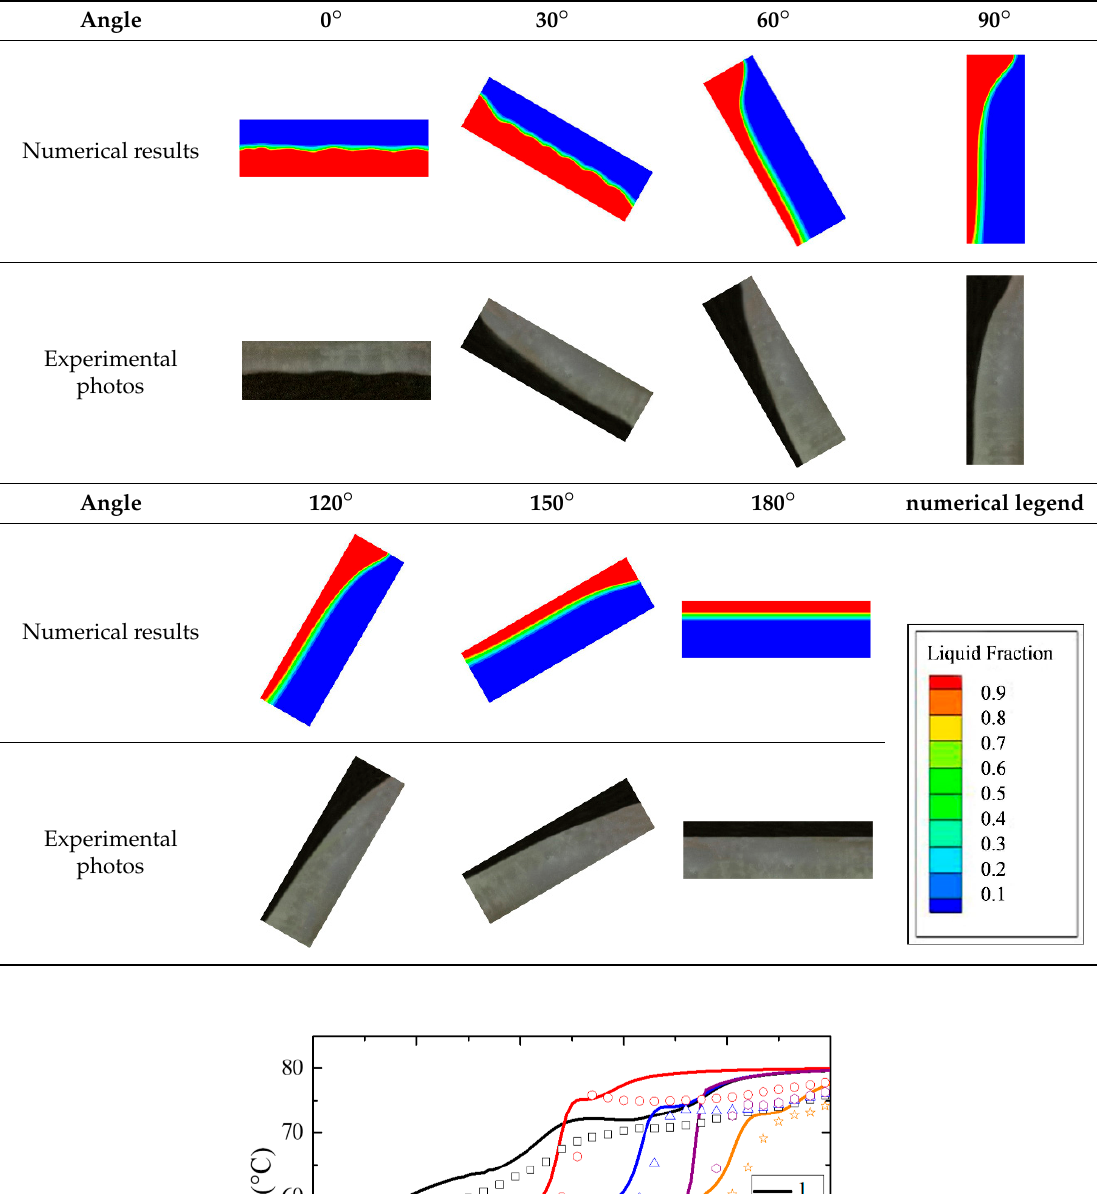
Table 4. Comparison of the locations of solid liquid interface between the numerical results and experimental photos.